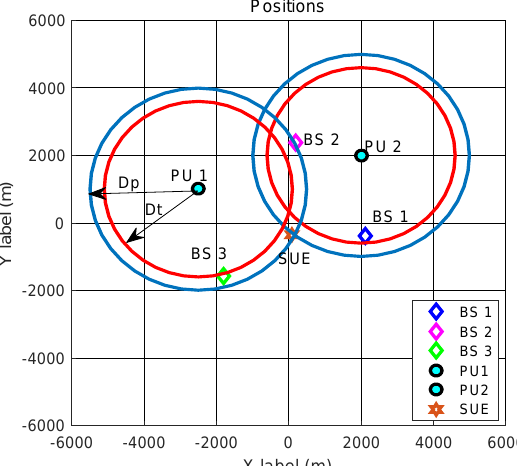
Figure 5. Spectrum sensing scenario in the cellular cognitive radio network